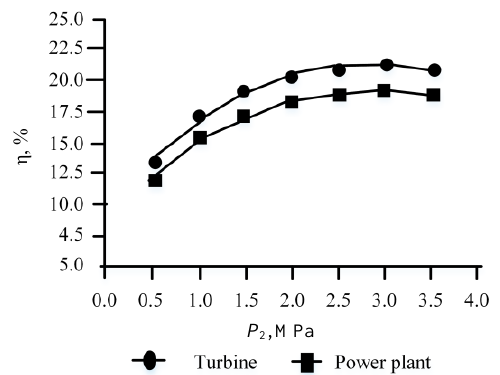
Fig. 7. Variation of the efficiency of the turbine and the power plant with pressure.